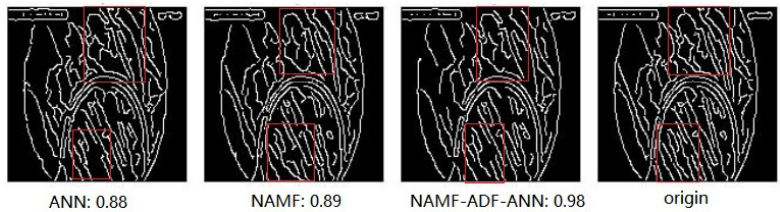
Figure 2. Edge detection